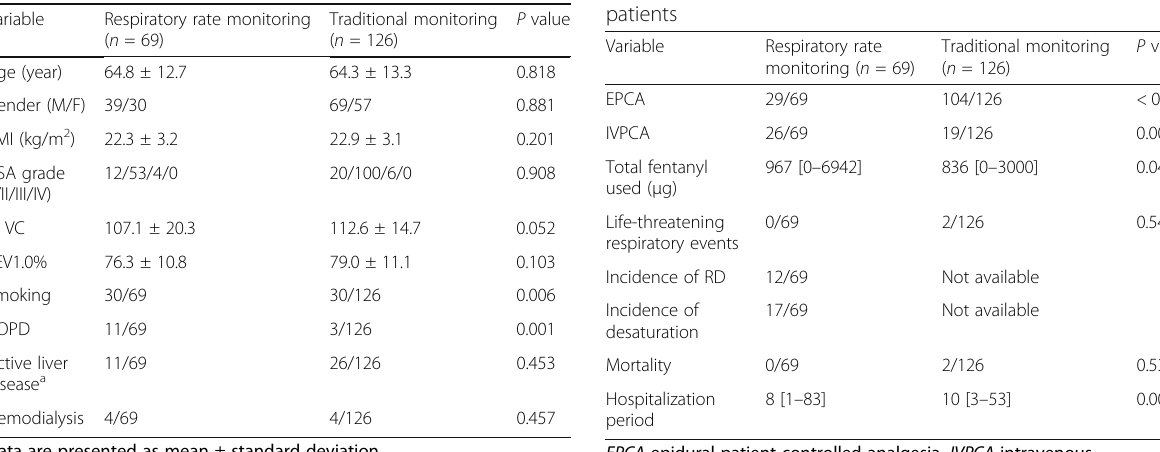
Table 4 Postoperative analgesia and outcomes of